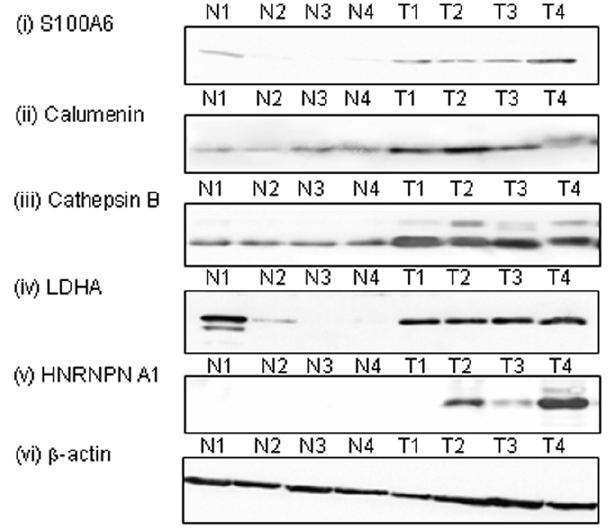
Figure 3. Verification of over-expression of proteins in EmCa tissues by Western blot analysis. Equal amounts of proteins (50 m g/ lane) were resolved on 10% sodium dodecyl sulfate (SDS)-polyacryl- amide gel and then electro-transferred onto polyvinylidene-difluoride (PVDF) membrane. After blocking, blots were incubated with respective mouse monoclonal antibody at appropriate dilutions at 4 u C O/N. Membranes were incubated for 2 h at room temperature with secondary antibody. Protein bands were detected by the enhanced chemiluminescence method (GE Health Care) on Kodak hyperfilm. Western blot analysis showed over expression of (i) S100A6, (ii) calumenin, (iii) cathepsin B, (iv) lactate dehydrogenase A (LDHA), and (v) heterogeneous protein A1 (HNRNPA1) in endometrial cancer tissues (T1, T2, T3 and T4) in comparison to normal endometrium (N1, N2, N3 and N4). b -actin served as a loading control showing equal protein amounts in each lane. doi:10.1371/journal.pone.0016352.g003 PLoS ONE |